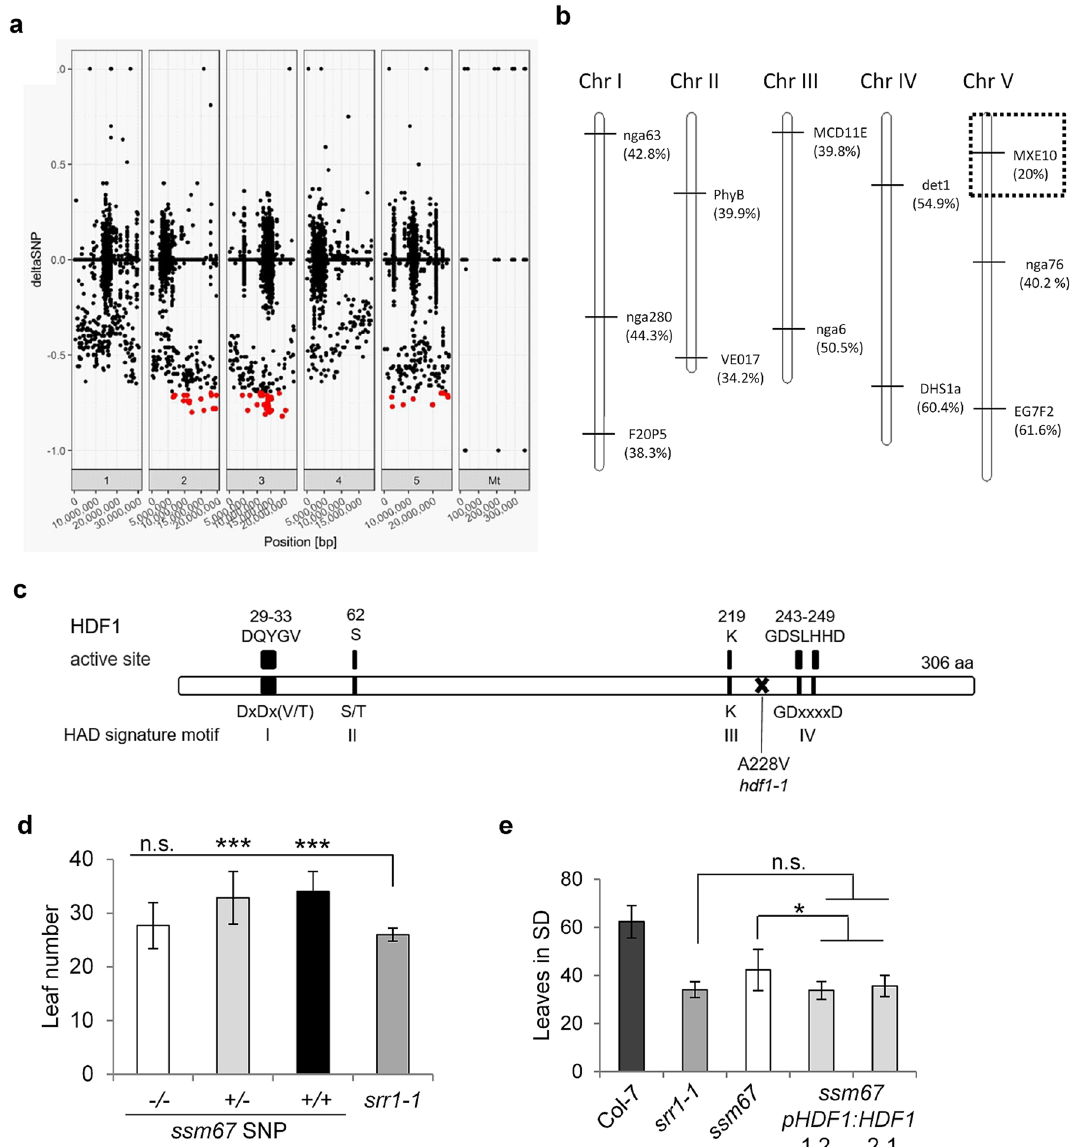
Figure 2. Identification of the causal mutation in ssm67. ( a ) Distribution of all identified SNPs in the ssm67 genome and their SNP index compared to the srr1-1 genome. A ΔSNP index closer to − 1.0 indicates SNPs unique for ssm67 . The red dots denote SNPs ≤ − 0.7, all SNPs below this value were evaluated as potential causal SNPs. ( b ) Linkage mapping of the causal mutation in a ssm67 × L. erecta mapping population using SSLP and CAPS markers. ( c ) Scheme of the At5g10460 Haloacid dehalogenase-like hydrolase (HAD). The position of the Ala to Val exchange is indicated. The consensus sequences of the HAD signature motifs I-IV are given below the boxes, the sequences of HDF1 are given above the boxes. ( d ) Flowering time of the segregating BC1F2 ssm67 population. Leaf number was scored in LDs for 10–12 plants each. −/− homozygous wt, +/− heterozygous for causal mutation, +/+ homozygous for causal mutation. Data are means ± s.d. A t test was employed to determine statistical significance (*** P ≤ 0.001, n.s. not significant). ( e ) Complementation of the ssm67 late flowering phenotype by genomic HDF1 . The leaf number of two independent lines homozygous for the genomic HDF1 construct in the ssm67 background, Col-7 wt plants, and the srr1-1 and ssm67 mutants was determined in SDs. For all lines, 15–20 plants were counted. Data are means ± s.d. A t test was employed to determine statistical significance. (* P ≤ 0.05, n.s. not